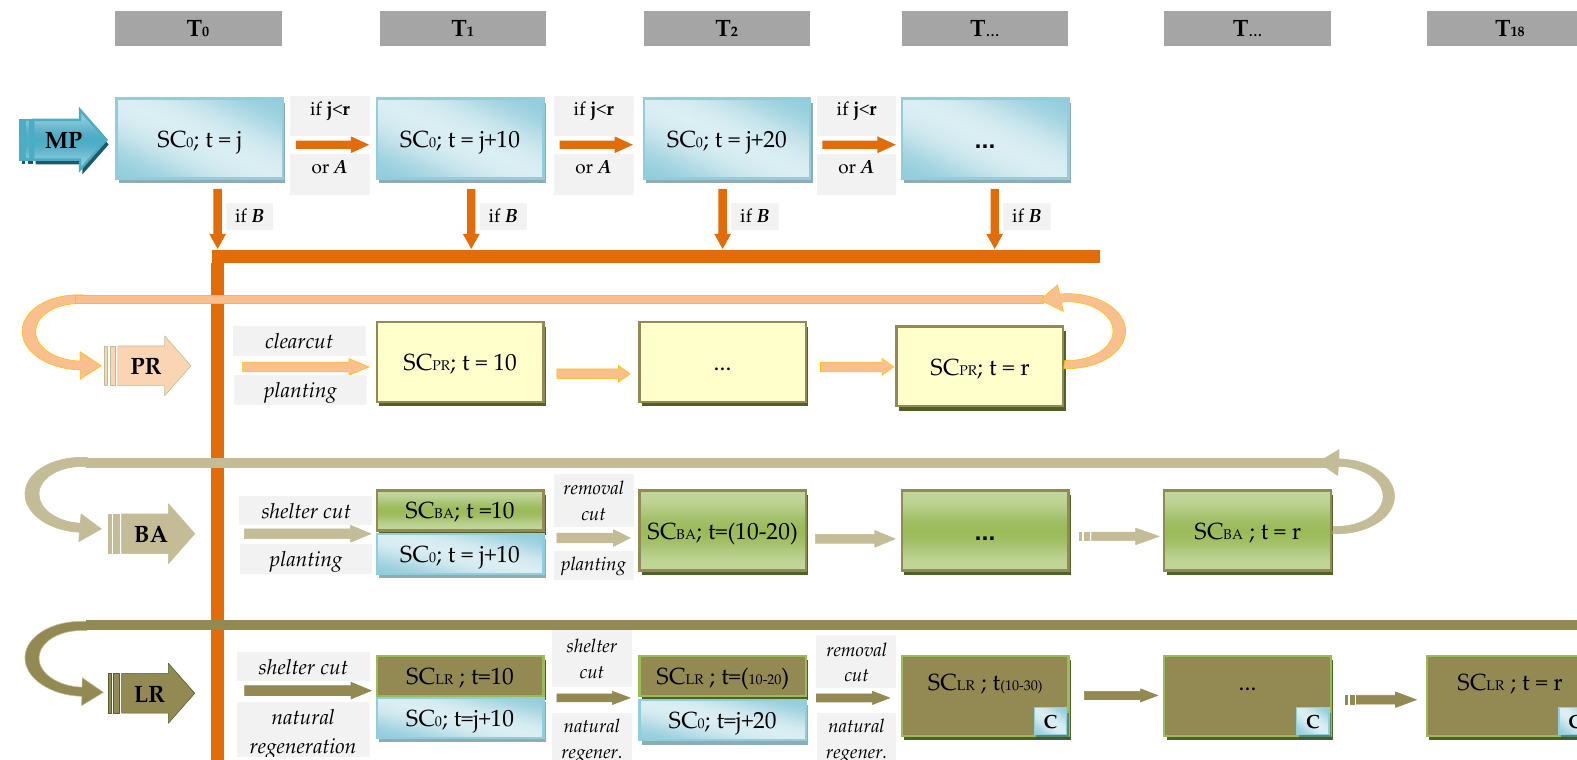
Figure 2. Simulation of species composition and age of tree stands in the various management scenarios. T 0 —Starting point; T 1 , T 2 , ... T 18 —10-year simulation periods; t —age of stand; j —age of stand at the starting point; r —rotation age for a given SC and management scenario, respectively; MP—data from the current management plan; PR, BA, LR—productive, basic, and long rotation scenarios, respectively; SC 0 —species composition of a stand at the starting point; SC PR, SC BA , SC LR —species composition of stands managed according to the productive, basic and long rotation scenarios, respectively; A—stand age ≥ rotation age, but spatial constrains do not allow for cutting; B—stand age ≥ rotation age and spatial constrains allow for cutting; C—5% of mature stand area excluded from harvesting. Figure 2 does not pertain to swamp sites.